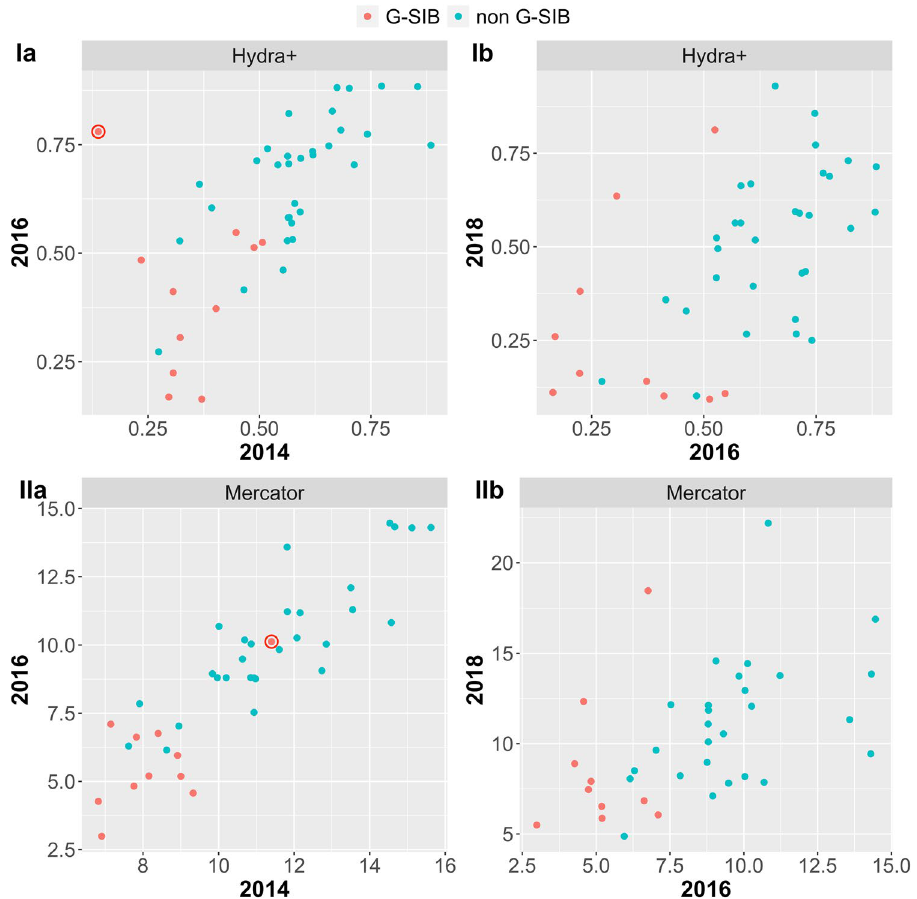
Figure 5. Changes in radial coordinate r (low values indicate high centrality) between 2014 and 2016 ( a ) and 2016 and 2018 ( b ) for the hydra+ -embedding ( I ) and the Mercator -embedding ( II ). Banks considered systemically relevant (G-SIBs) at the end of the time period are marked in red. Nordea bank is circled in the panel Ia and IIa; see text for